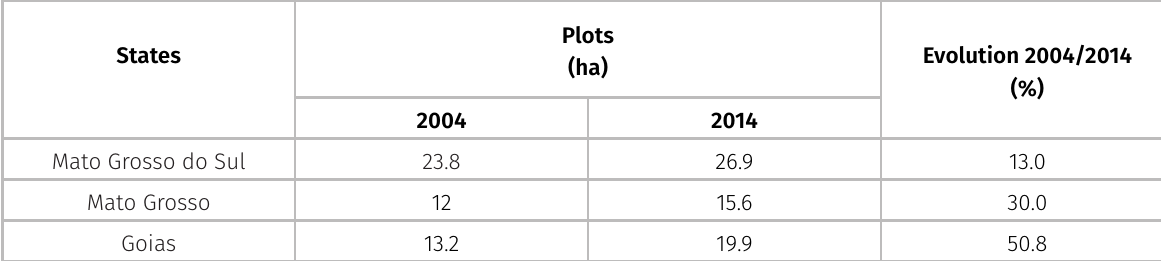
Table III. Average size used for agricultural and livestock production in the plots of settlements in the Midwest region, in 2004 and 2014 by